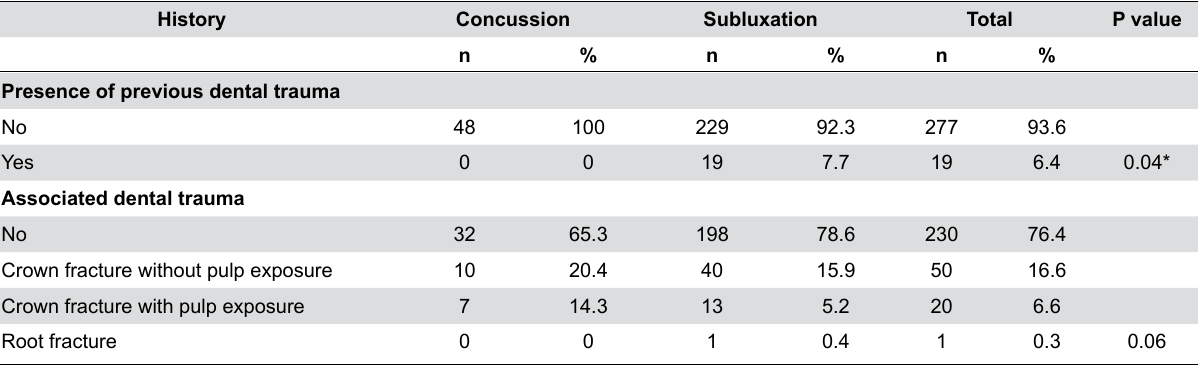
Table 2- Dental history regarding previous and current dental